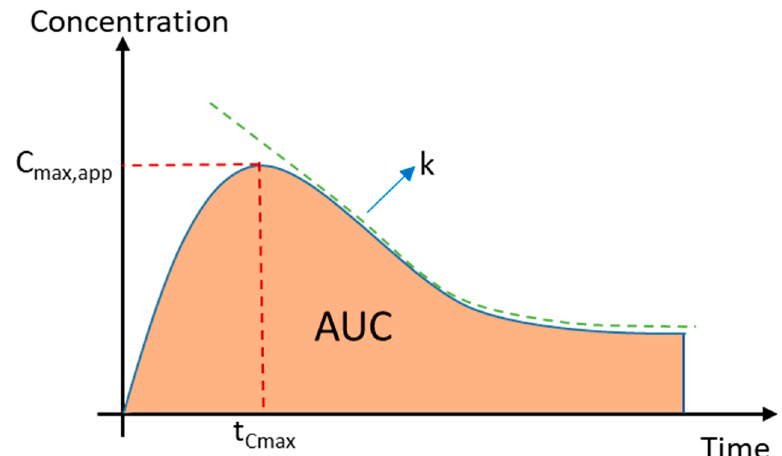
Figure 9. Concentration–time profile of the supersaturated system showing the apparent maximum concentration (C max,app ), area under the curve (AUC), and crystallization rate constant (k).